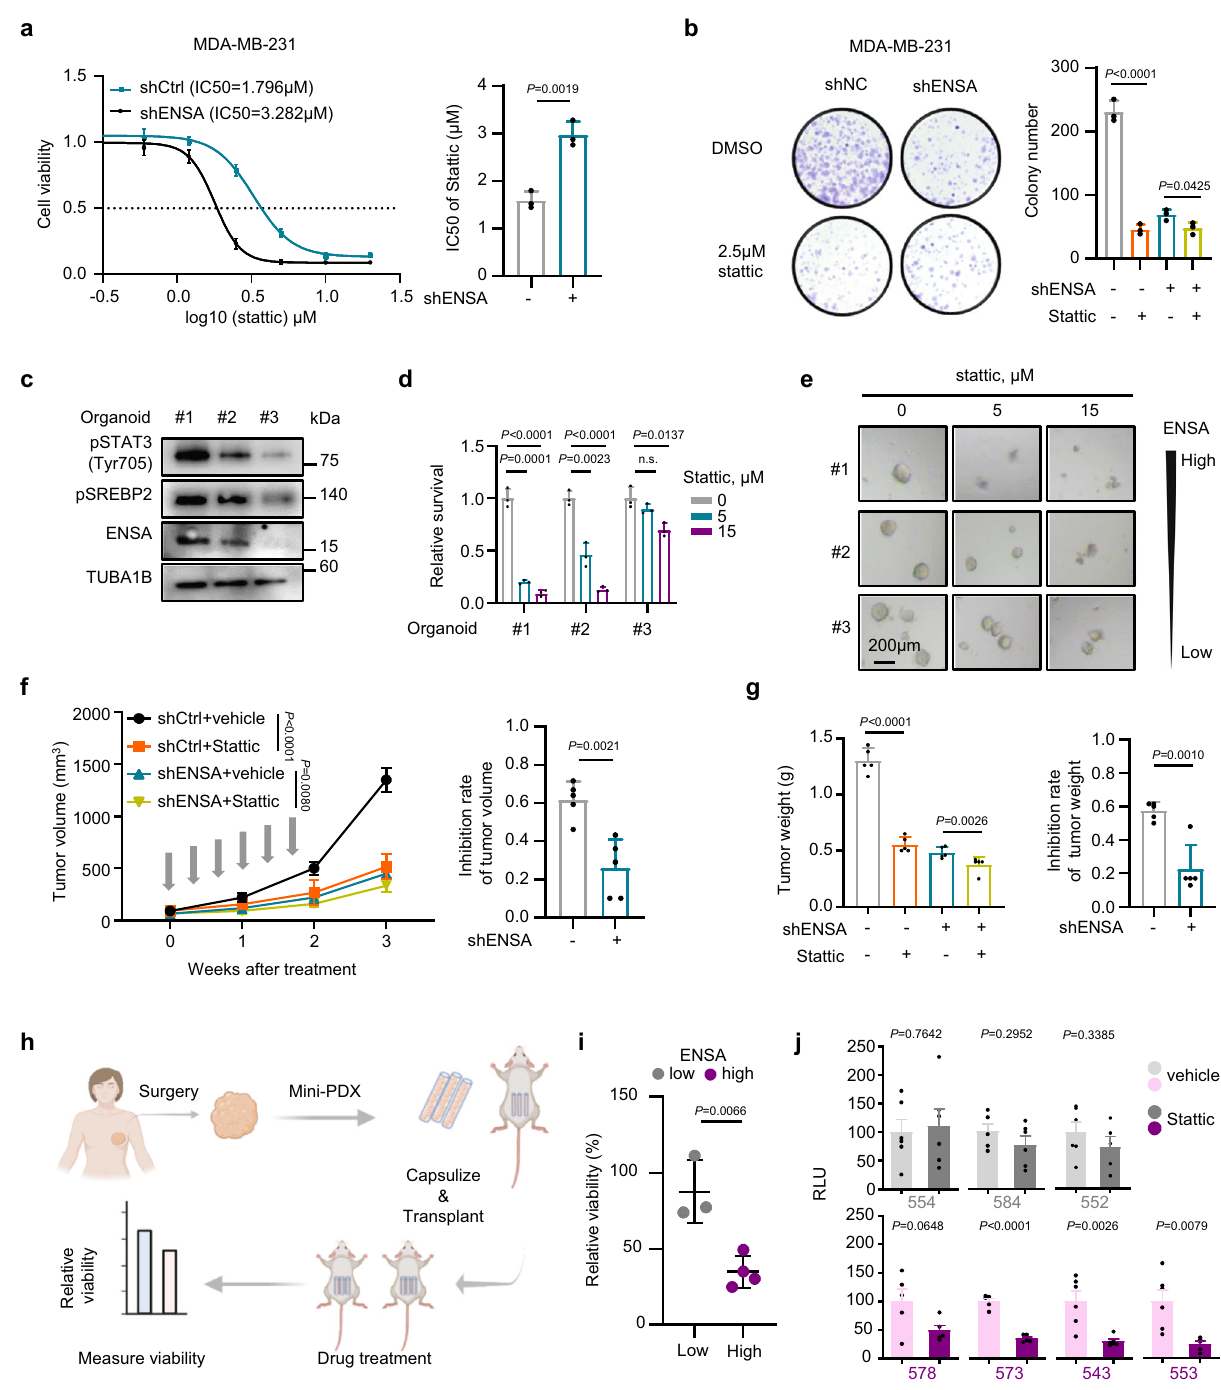
Short hairpin RNA (shRNA) vectors and lentiviral infections of cells . The two shRNAs with the best knockdown ef fi ciency (shENSA-1: GAGCTGAAGAGG CAAAGCTAA; shENSA-2: CTGCCAGATCCTGAGACGCTT) were cloned into the pLKO.1 vector and introduced into HEK293T cells together with packing plasmids (psPAX2 and pMD2. G) and standard Lipofectamine 2000 transfection reagent (Thermo Fisher Scienti fi c) to generate lentiviruses. The viral supernatants were collected and applied to infect TNBC cell lines in the presence of polybrene (10 µg/ml; Sigma-Aldrich). A plasmid expressing a nontargeting shRNA was used as the negative control. Small interfering RNA (siRNA) delivery . siRNAs targeting human STAT3 (siSTAT3-1: GCAAAGAATCACATGCCACTT; siSTAT3-2: GGCGTCCAGT